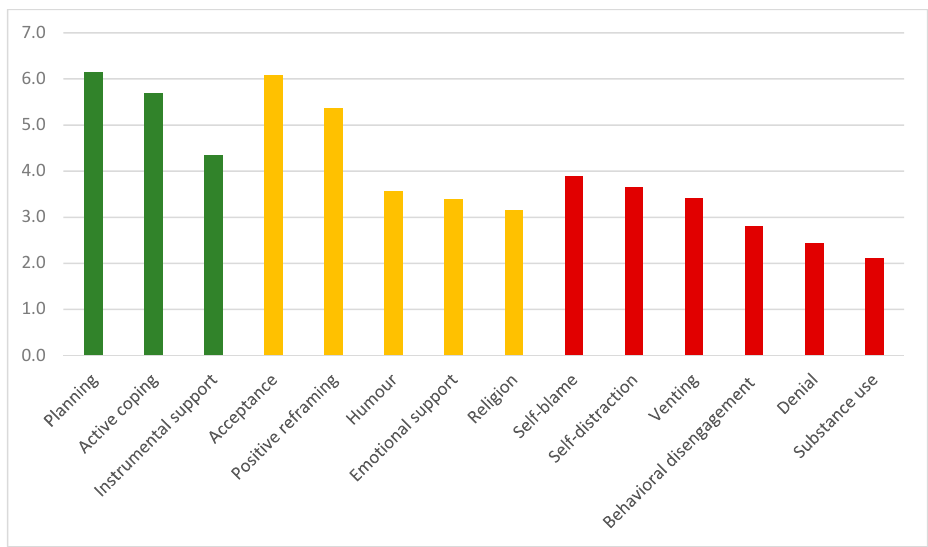
Figure 2. Brief-COPE scores of the 14 coping styles referred to the 3 composite dimensions measuring problem-focused strategies (green bars), emotion-focused strategies (yellow bars), and dysfunctional coping strategies (red bars) (entire sample of 38 volunteers). Table 6. Coping scale data of Civil Protection volunteers serving during the COVID-19 pandemic compared to those non-serving during the COVID-19 pandemic.